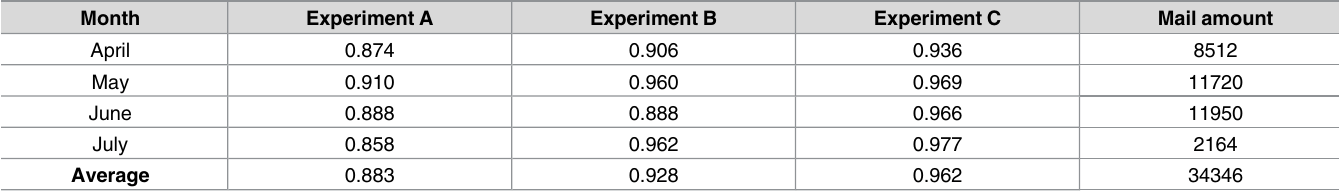
Table 4. The F-measure values of three